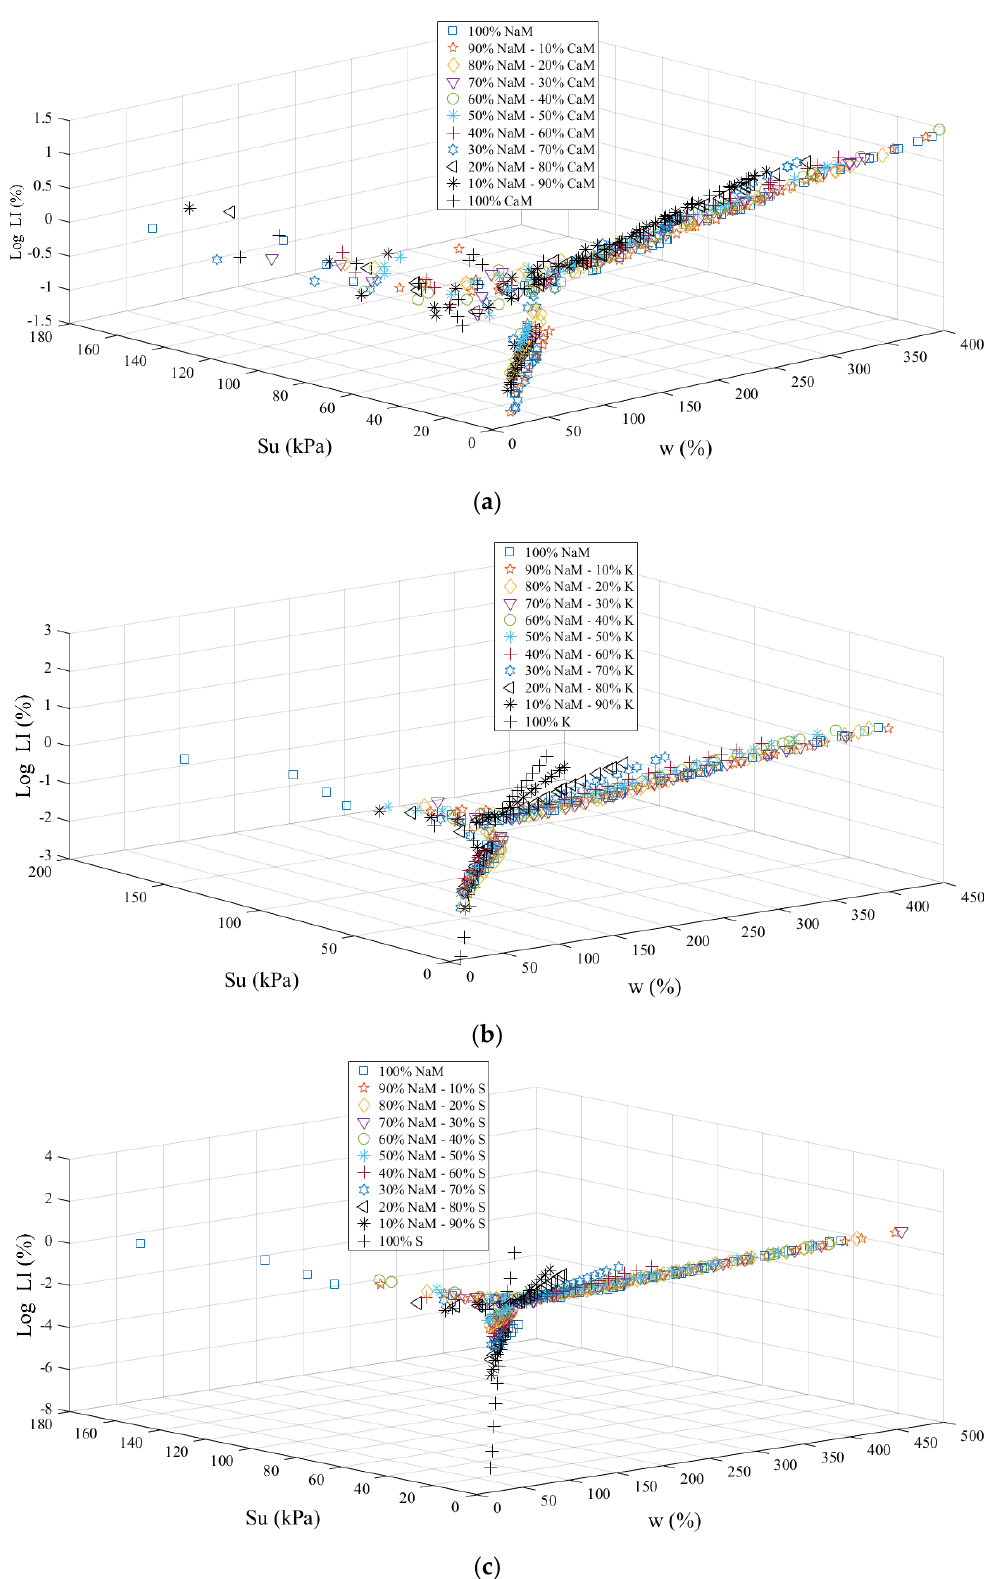
Figure 6. Relationship among undrained shear strength, water content and log liquidity index